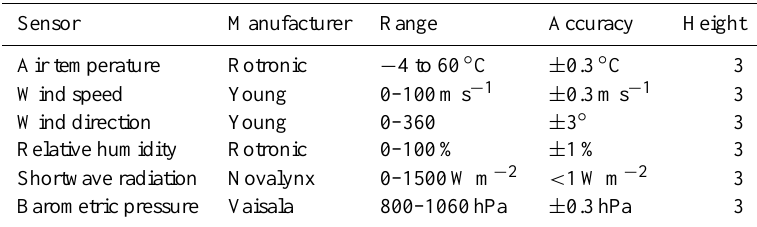
Table 1. Technical specification of the SIMA